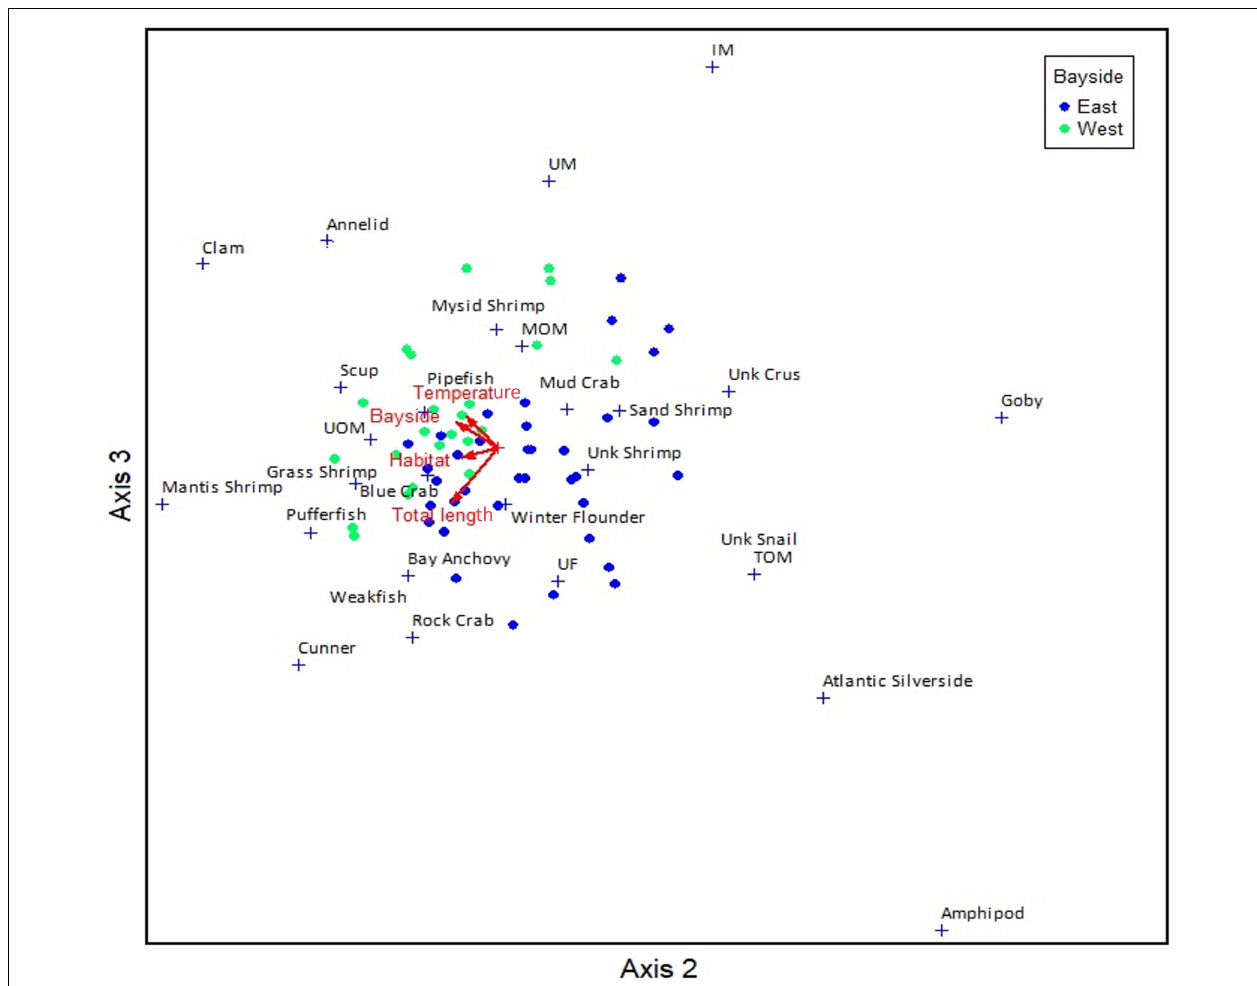
FIGURE 3 | Canonical correspondence analysis (CCA) plot for Axis 2–3, color coded by Bay regions (East/West). Arrows represent significant explanatory factors; dots represent individual summer flounder and + symbols represent centroids of individual prey items